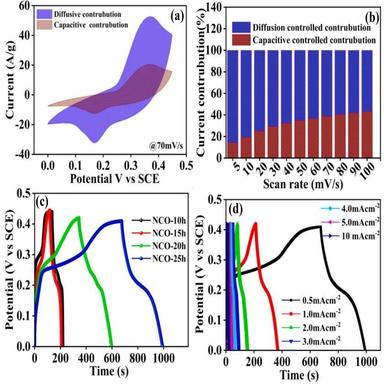
(a) comparison of diffusive and capacitive contribution in CV, (b) diffusive and capacitive contributions at various scan rates of NCO-25 sample, (c) GCD profiles for all four NCO samples at 0.5 mAcm− 2 current density, (b) GCD profile for the representative NCO-25 sample at various current densities.